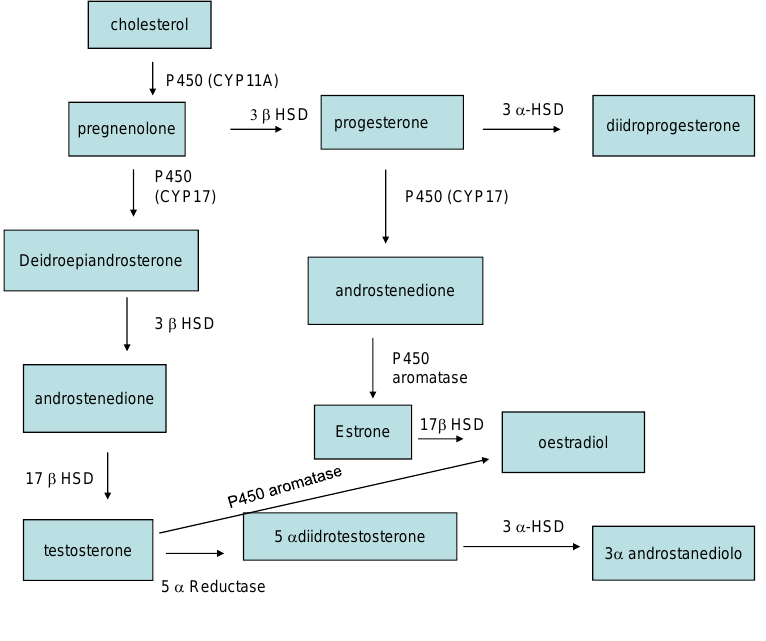
Figure 2. Biochemical pathway from cholesterol to steroid